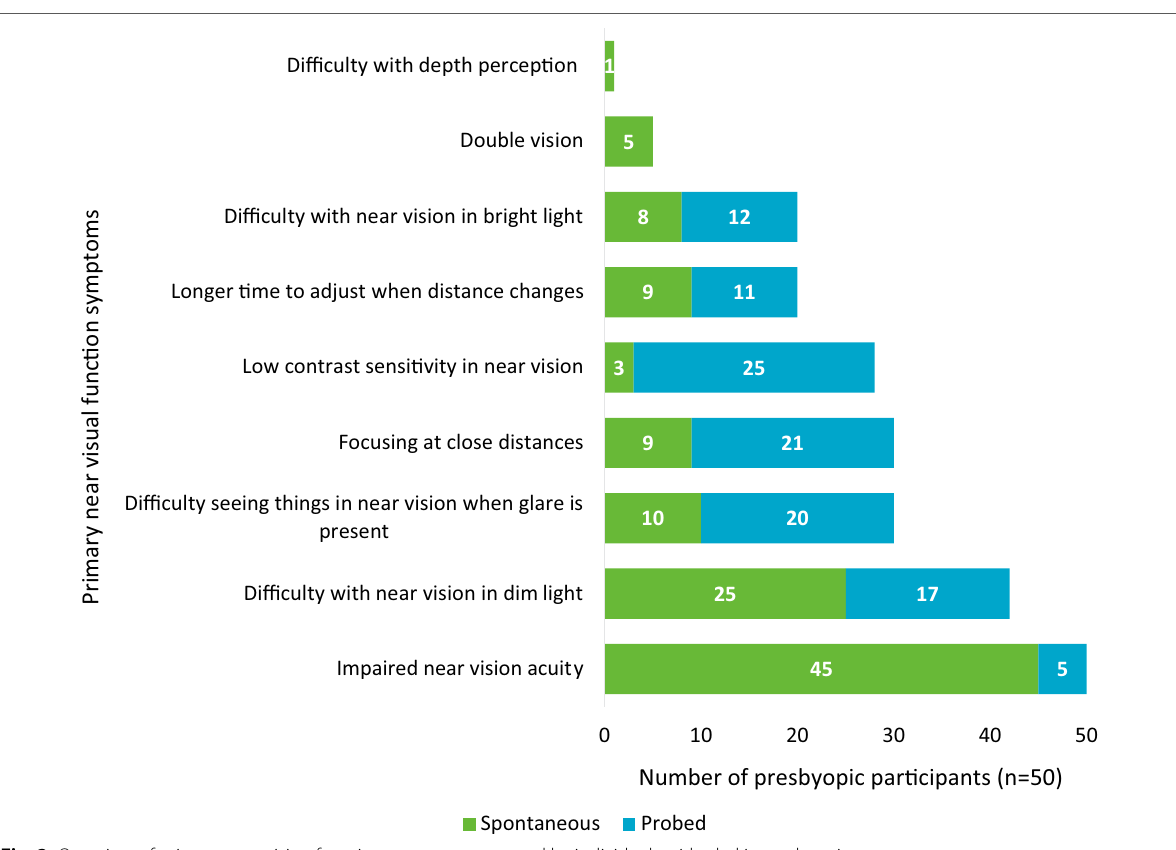
Fig. 2 Overview of primary near vision function symptoms reported by individuals with phakic